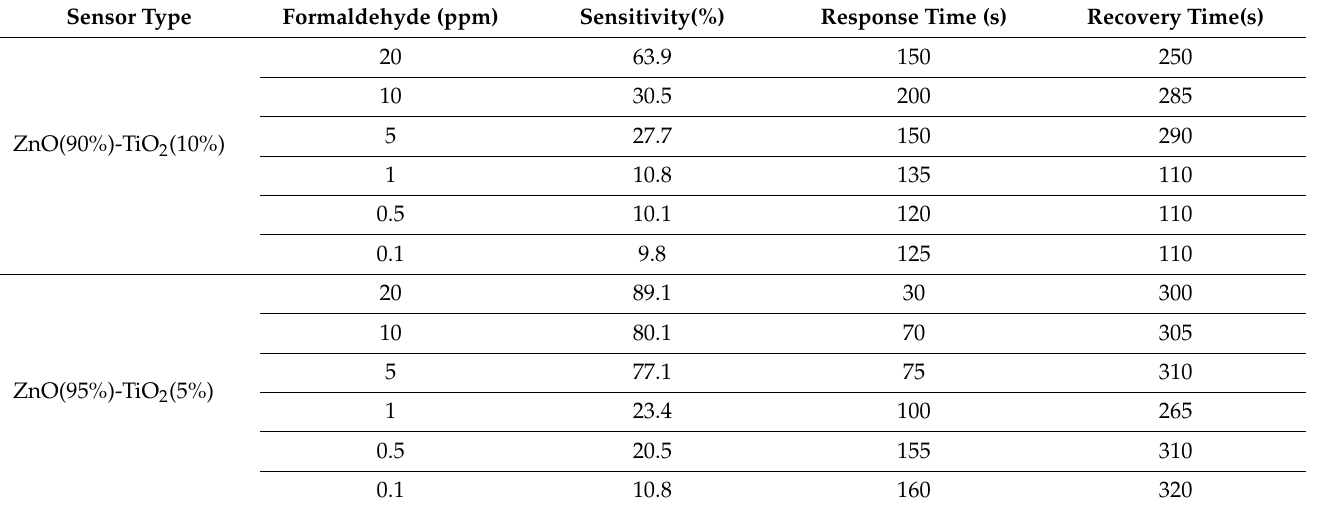
Figure 9. Sensitivity characteristics by concentration of formaldehyde gas of gas sensor by TiO 2 ratio. Table 2. Summary of sensor characteristics for formaldehyde gas by sensor.